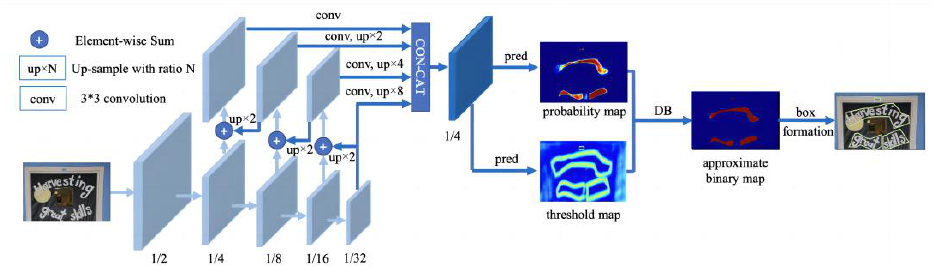
Figure 3. DBNet model network structure.